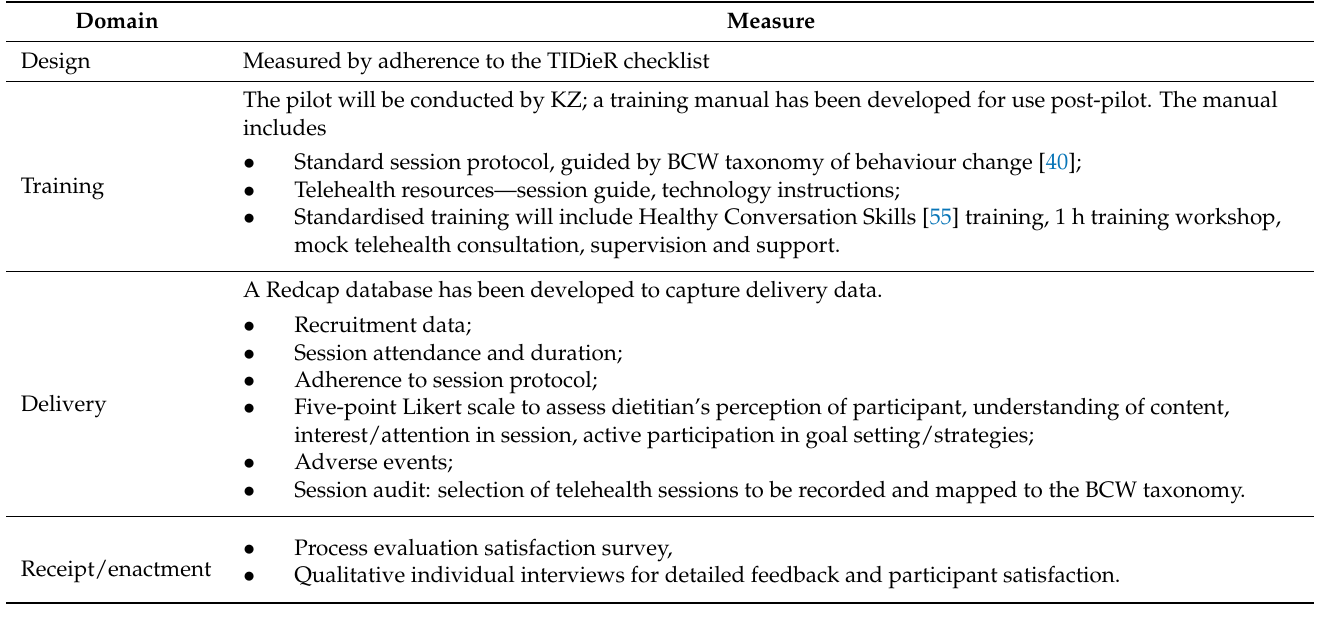
Table 4. NIH Treatment Fidelity